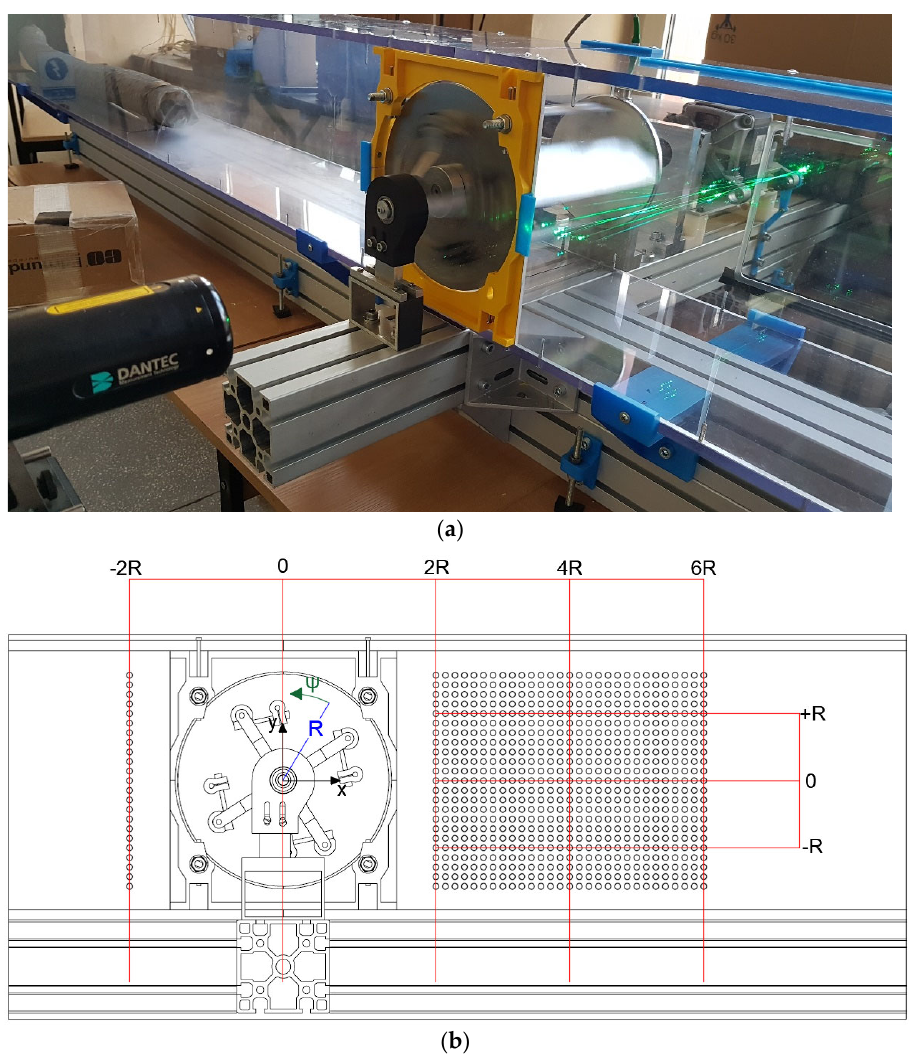
Figure 12. Comparison between the model and the actual function together with standard uncertain ‐ ties.